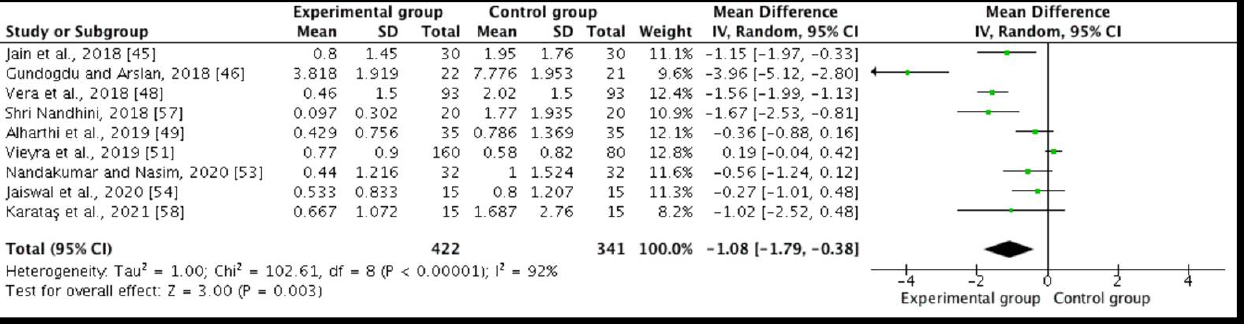
Figure 5. Forest plot comparing postoperative pain between the experimental group (intracanal cryotherapy) and the control group (room temperature) at 48 h. 3.4. Postoperative Pain at 72 h Five studies ( n = 563) revealed postoperative pain at 72 h [46,48,51,53,58]. However, one study had zero scores for the mean and standard deviation for the intracanal cold therapy group (experimental group) [53]; therefore, the MD and CI were not estimable and they were not included in the statistics. A meta-analysis demonstrated a significant statistical diminution in postoperative pain in the intracanal cold therapy group (experimental group) compared with the room temperature irrigant group (control group) (MD = −0.69; 95% CI = −1.34 to −0.05; p = 0.04; I 2 = 90%) (Figure 6). The GRADE was low because of concerns with the RoB 2 and the substantial heterogeneity, which indicated that “we have little confidence in the effect estimate and the true effect might be markedly different from the estimated effect” (Table 2).